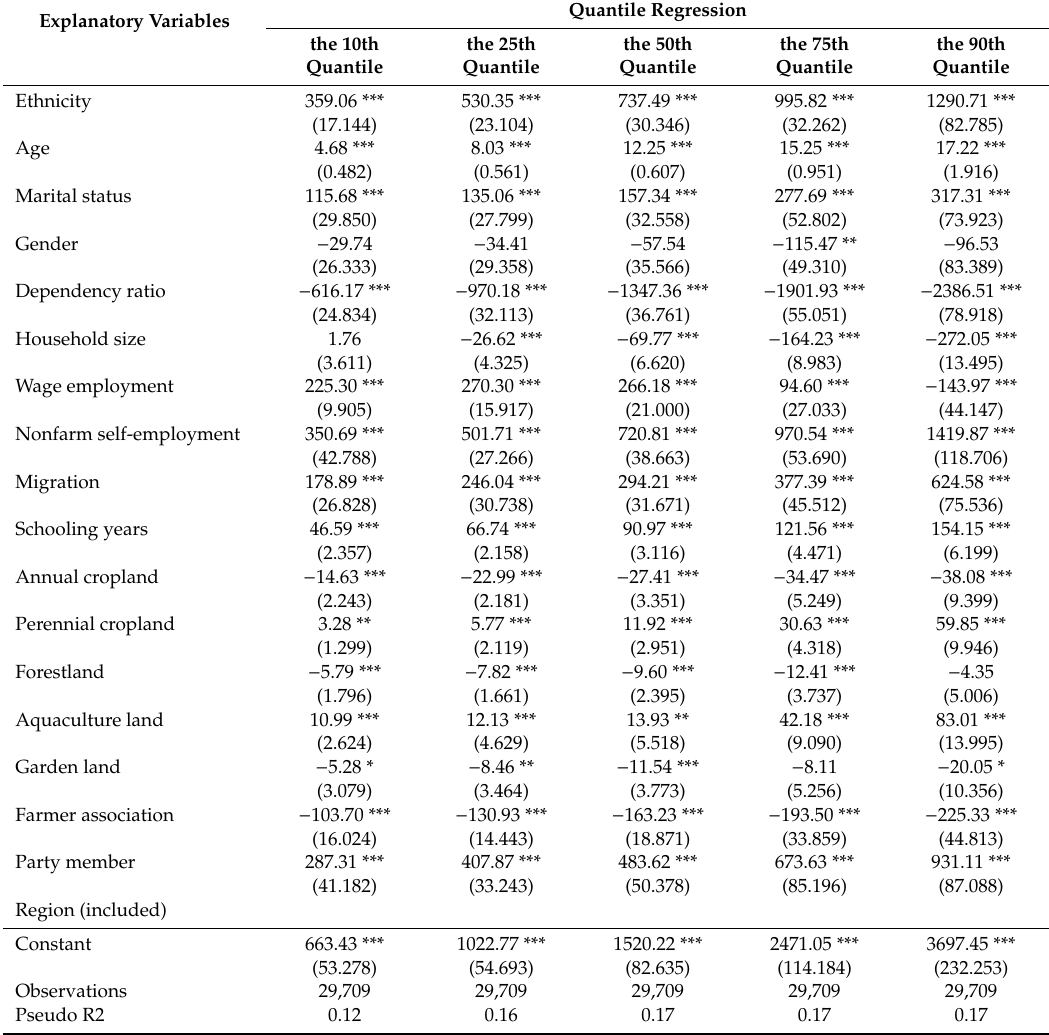
Table 4. Quantile e ff ects of schooling years on household